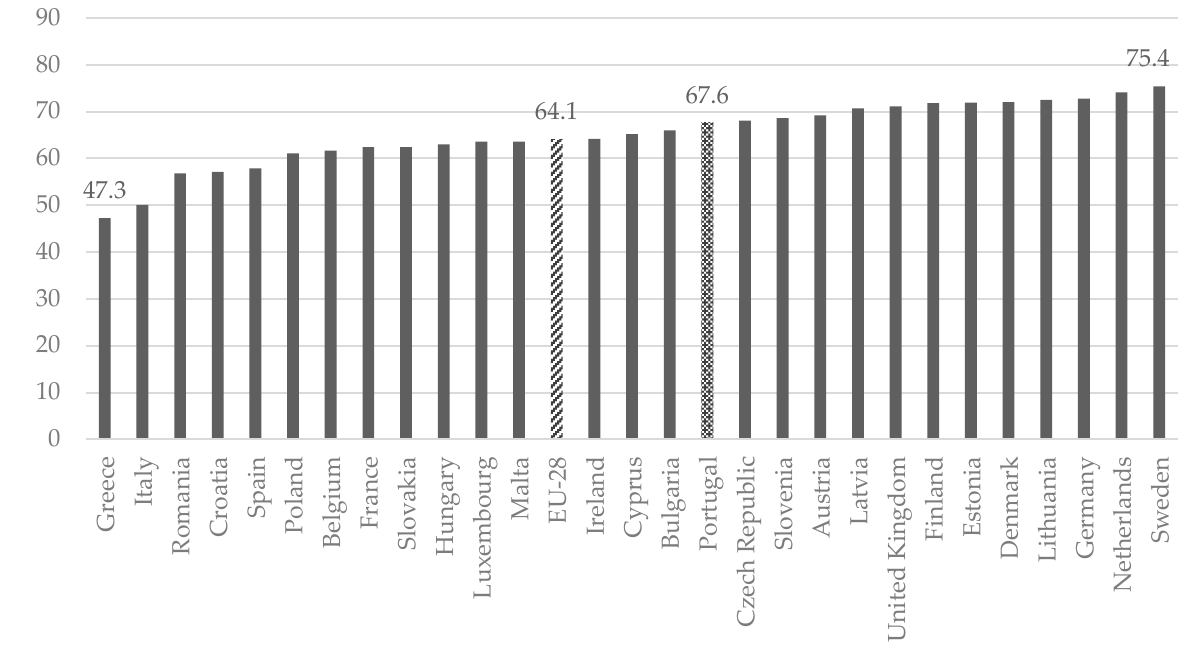
Figure 1. Employment rates of women (aged 15–64) in the EU-28, 2019 (%). Source: Eurostat (2020). The characteristics that account for Portugal being considered a singular analytical case include the evidence that both women and men work on a full-time and continuous basis throughout their life course (Addabbo et al. 2015; Casaca 2012; Torres et al. 2018; Wall et al. 2016). In fact, 89.1% of all Portuguese women in employment (aged 15–64) were working on a full-time basis in 2019. Such a pattern was the dominant one in the time span under analysis. When women work part-time, the main reason given is the difficulty in finding a full-time job, suggesting that part-time work is mostly involuntary. Moreover, Portugal has the third highest employment rate (82.7%) for women (aged 20–49) with small children (aged under six) in the EU, immediately after Sweden (83.6%) and Slovenia (82.8%), and well above the EU-28 average (64.7%) (Figure 2). Furthermore, contrary to the predominant pattern of career interruption after childbirth among women in the EU, the employment rate in Portugal is slightly higher for women with children than it is for those women without children (81.6%) (Eurostat 2020). Data relating to this particular indicator for Portugal have only been available since 2005, and reveal a steady growth in the employment rates of women with children under 6 years of age, especially since 2012, increasing by more than 10 p.p. until 2019 (from 71.6% to 82.7%). Despite the decreasing gap in the employment rates of Portuguese women and men, empirical evidence reveals the enduring patterns of segregation on the grounds of gender. Significant inequalities between men and women still persist, with female workers out- numbering their male counterparts in precarious jobs, unemployment, and less valued and poorly paid occupations, at the bottom of the hierarchical ladder (Addabbo et al. 2015; Coelho and Ferreira 2018; Torres et al. 2018).